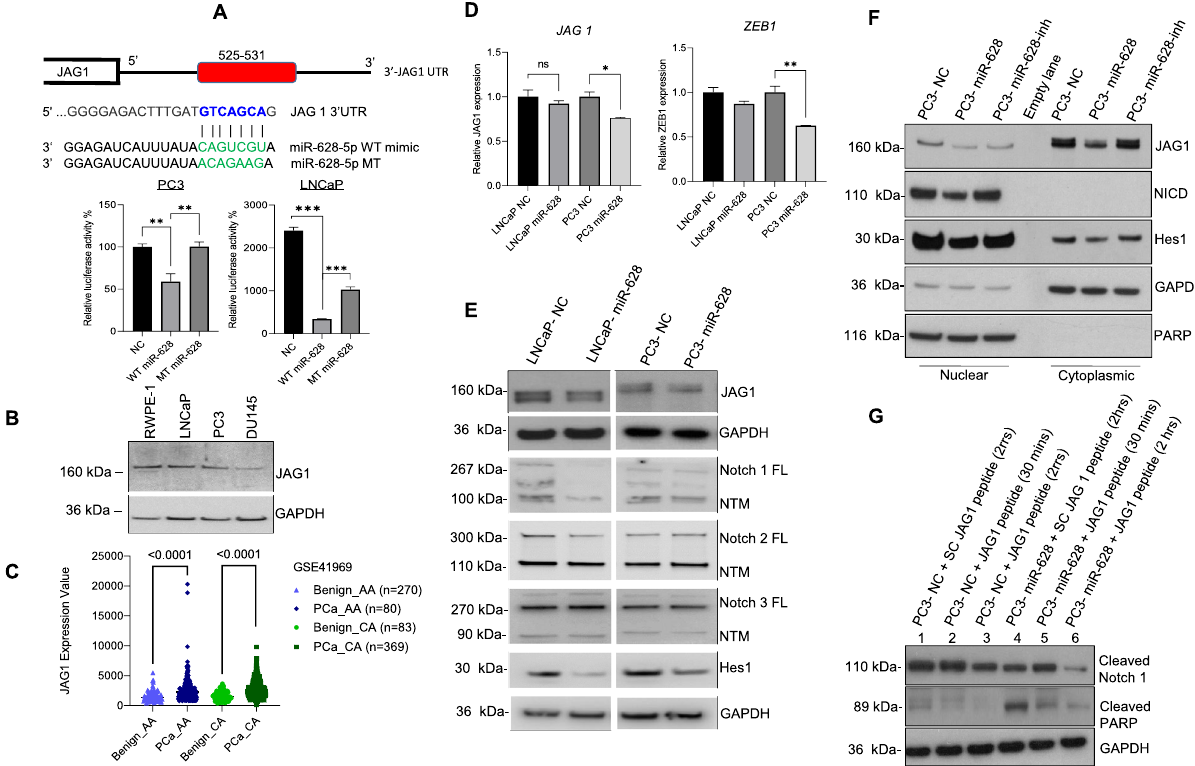
Figure 5. MiR-628 targets JAG1 in PCa cells and affect JAG1 downstream Notch signaling in PCa cells. ( A ) Jagged-1 was identified as a potential miR-628 target using Targetscan. Wild type and mutant target sequences of miR-628 are shown. miR-628 and JAG1 - 3 ′ UTR interaction was assessed through luciferase assay in LNCaP and PC3 cells transfected with wild type miR-628 (WT) or mutant type miR-628 (MT) (**p < 0.01, ***p < 0.001). ( B ) JAG1 expression was assessed in RPWE-1 and PCa cells by western blotting. Membranes were cut before hybridization using the molecular weight marker as a reference and imaged using an Azure imaging system. All western blot full images are provided in supplementary information files. ( C ) JAG1 expression was assessed utilizing the GSE41969 dataset and analyzed using the GEO2R web tool in matched benign and PCa samples obtained from AA and CA men. Light blue triangles = benign AA (n = 80), dark blue diamonds = PCa AA (n = 270), light green circles = benign CA (n = 83), and dark green squares = PCa CA (n = 369), (p < 0.0001). ( D ) Effect of mir-628 on the expression of JAG1 and ZEB1 expression as measured by RT/qPCR in LNCaP and PC3 cells after transfection with 100 nM of miR-628 mimic or NC (*p < 0.05, **p < 0.01). ( E ) Protein expression of JAG1, Notch 1, Notch 2, Notch 2, and Hes1 is shown in LNCaP and PC3 cells after transfection with 100 nM of miR-628 mimic or NC. Membranes were cut before hybridization using the molecular weight marker as a reference and imaged using an Azure imaging system. All western blot full images are provided in supplementary information files. ( F ) Protein expression of JAG1, Notch intracellular domain (NICD), and Hes1 are shown in PC3 cells nuclear and cytosolic fractions after transfection with 100 nM of miR-628 mimic, miR-628 inhibitor, or NC. PARP and GAPDH were used as loading controls for nuclear and cytosolic protein fractions and imaged using film. ( G ) Protein expression of cleaved Notch1, cleaved-PARP are shown in PC3 cells after transfection with 100 nM of miR-628 mimic, miR-628 inhibitor, or NC and treatment with Scrambled control JAG1-peptide (SC) or JAG1-peptide for 30 min or 2 h and imaged using